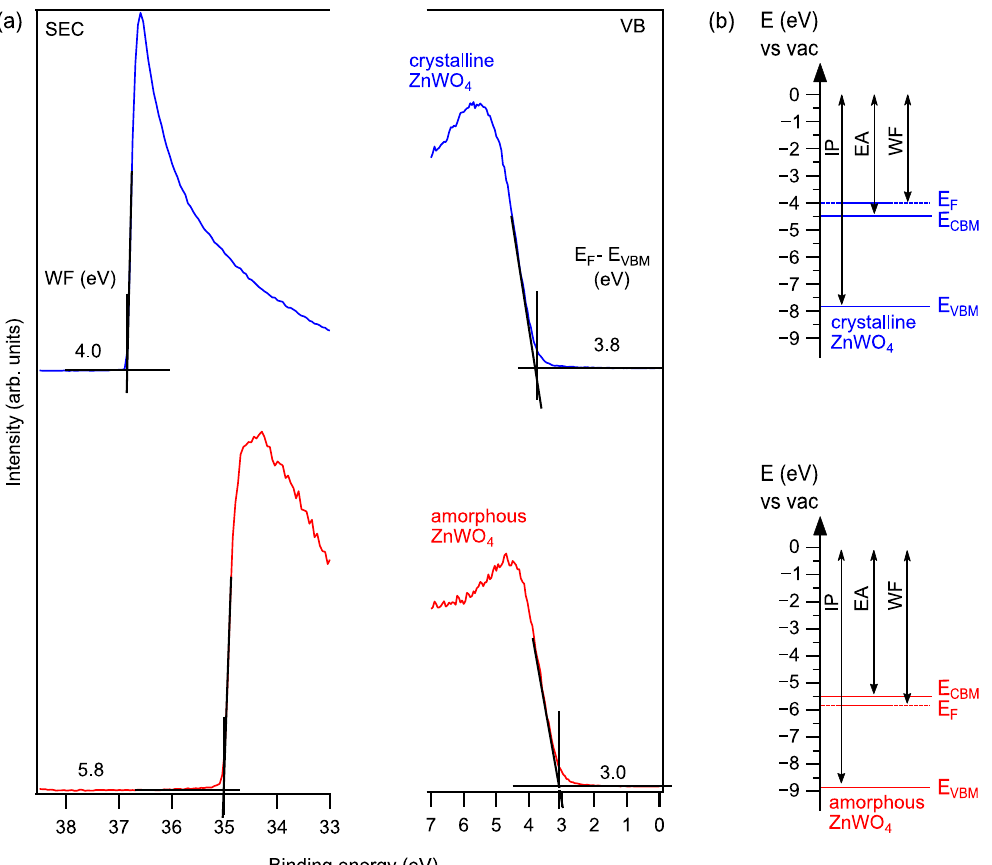
Figure 5. ( a ) UP spectra of the secondary electron cutoff (SEC) and valence band (VB) regions and ( b ) band diagrams of crystalline monoclinic ZnWO 4 and amorphous ZnWO 4 . WF: work function; E F : Fermi level; CBM: conduction band minimum; VBM: valence band maximum; IP: ionization potential; EA: electron affinity.